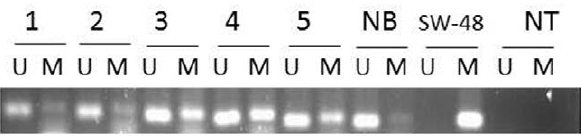
Figure 1. MSP analysis of the promoter region of SLC5A8 in five patients with adenoma. The presence of visible PCR product in lanes ‘‘U’’ indicates the presence of unmethylated genes of SLC5A8, the presence of product in lanes ‘‘M’’ indicates the presence of methylated genes. Water controls for PCR reaction are also shown as NT: no template. MSP of SLC5A8 in NB: Normal Blood lymphocyte DNA used as control for unmethylated at SLC5A8, SW48: colon cancer cell line used as a positive control. Patients # 3–5 are methylated, and patients # 1– 2 are semimethylated.